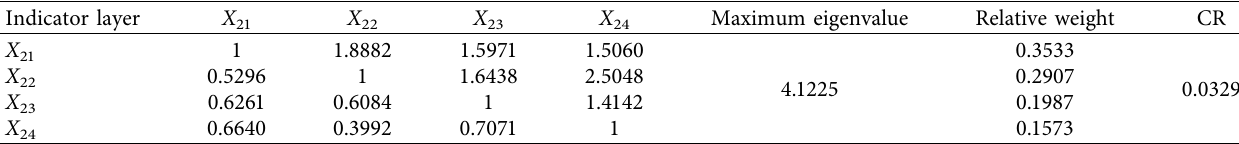
Table 15: Judgment matrix and weights of indicator layer indices in criterion B